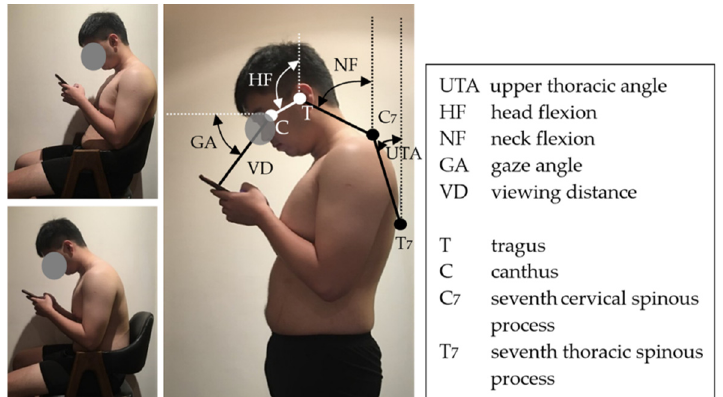
Figure 1. Schematic of anatomical markers and of measured angles and distance.